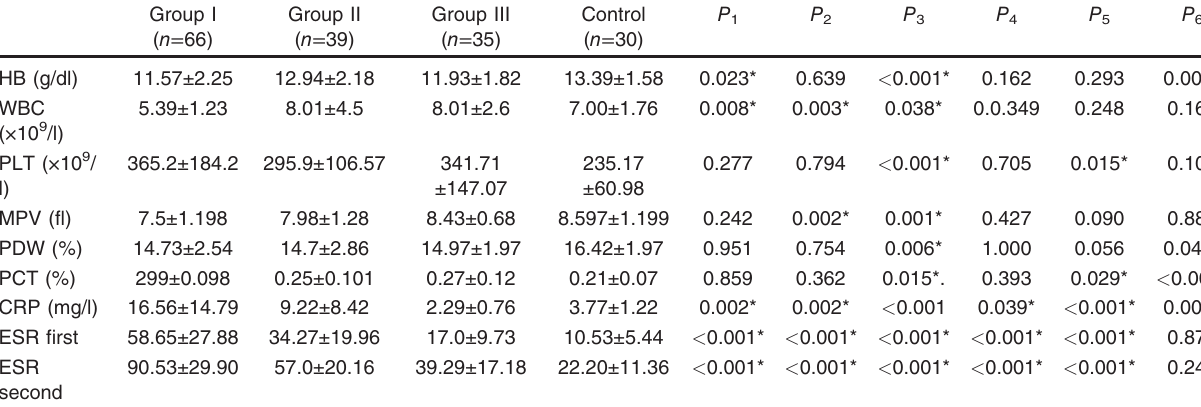
Table 2 Laboratory data of the study groups